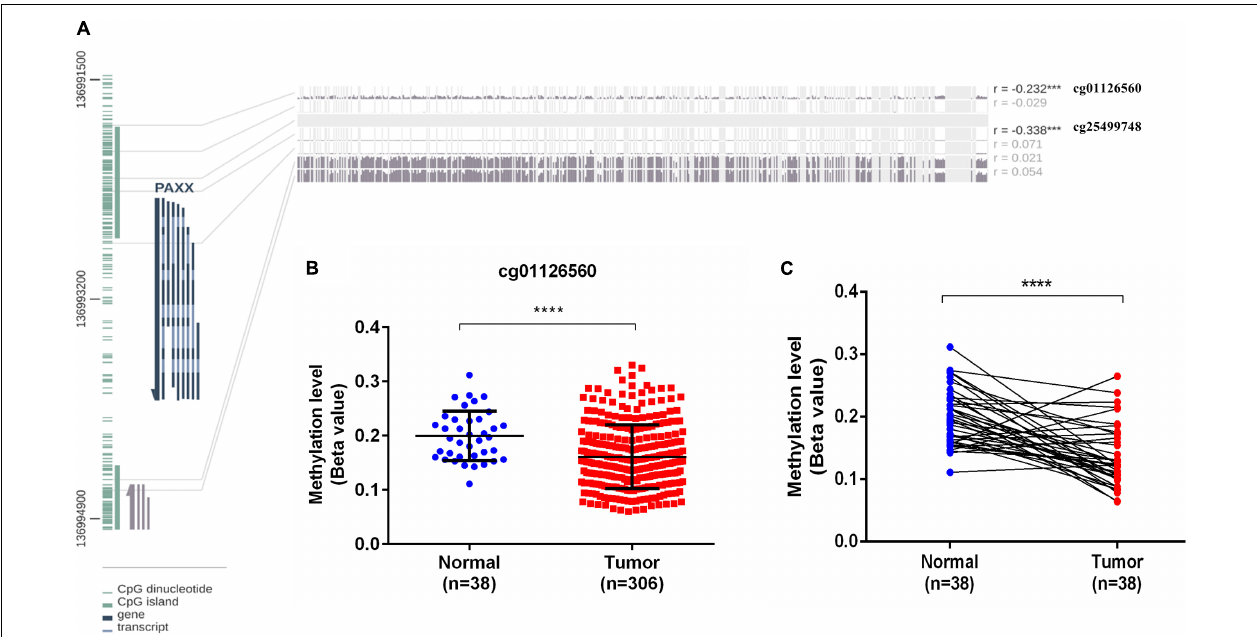
FIGURE 7 | DNA methylation analysis of the PAXX gene from TCGA-COAD dataset. (A) Graphical representation of CpG Island and sites around PAXX genomic locus with Pearson’s correlation values of PAXX expression with methylation of different CpG sites. (B) Comparison of DNA methylation levels of cg01126560 between total normal and colon cancer tissues. (C) Comparison of DNA methylation levels of cg01126560 between paired normal colon and colon cancer tissues. * p < 0.05, ** p < 0.01, *** p < 0.001, **** p <